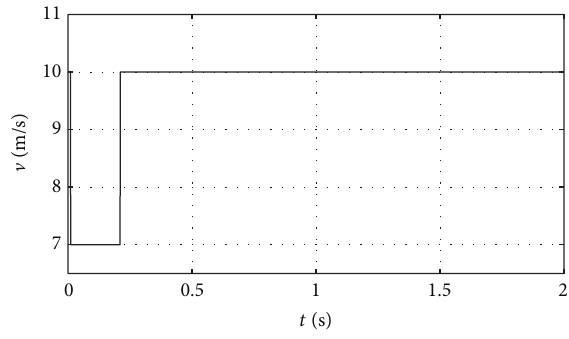
Figure 10: Wind speed variable.